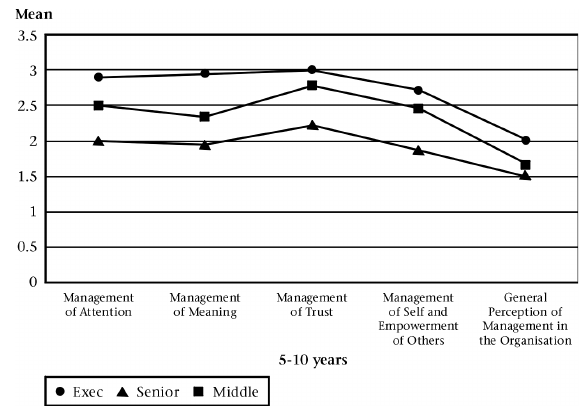
Figure 8: Mean per Dimension per Management Level – 5-10 Years of Service